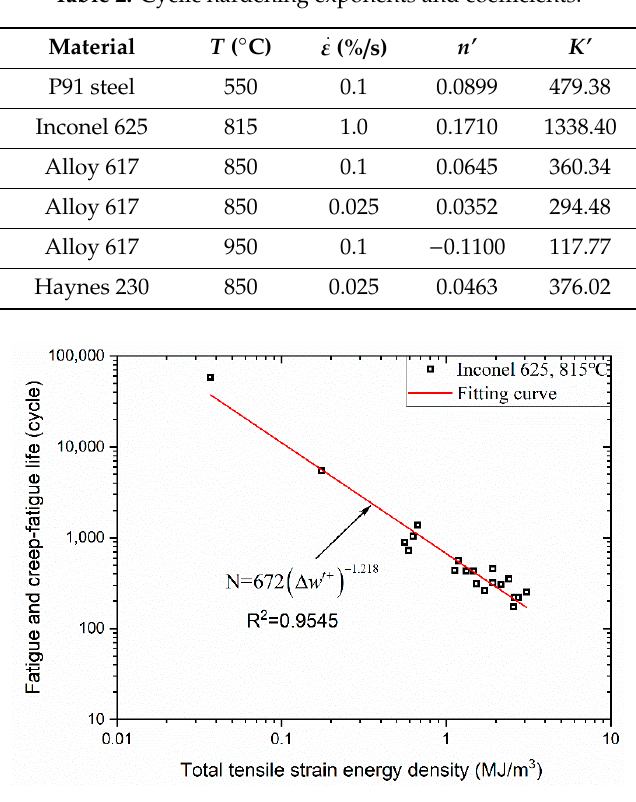
Table 2. Cyclic hardening exponents and coe ffi cients.